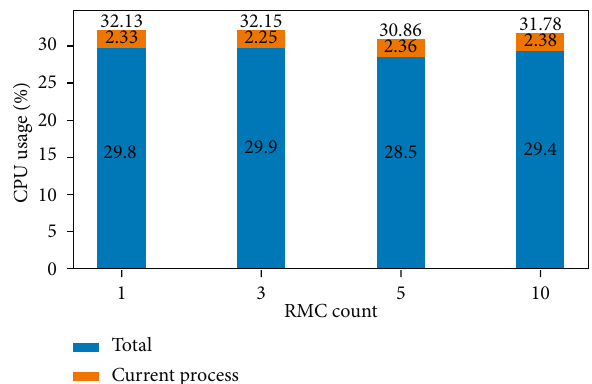
Figure 7: The processing time of DTS communicates with